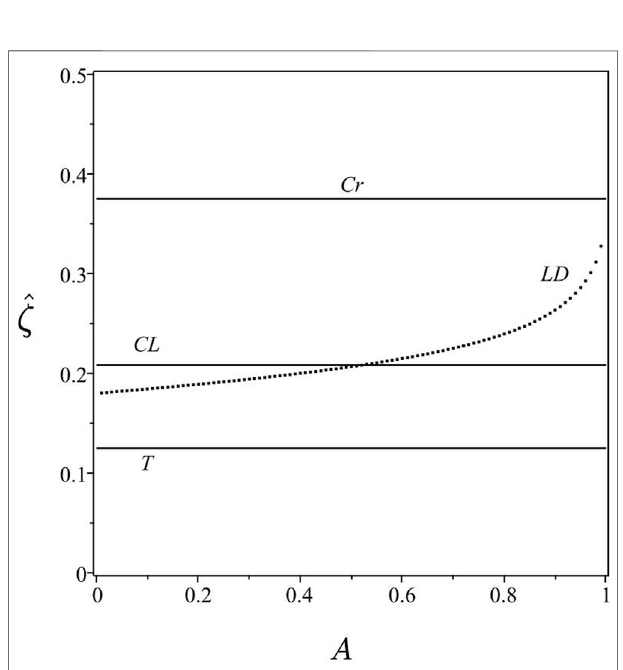
FIGURE 10 | Scaled curvature as a function of the Atwood number for the critical (Cr), convergence-limit (CL), Taylor (T) and Layzer-drag (LD) spikes for kG (cid:1)